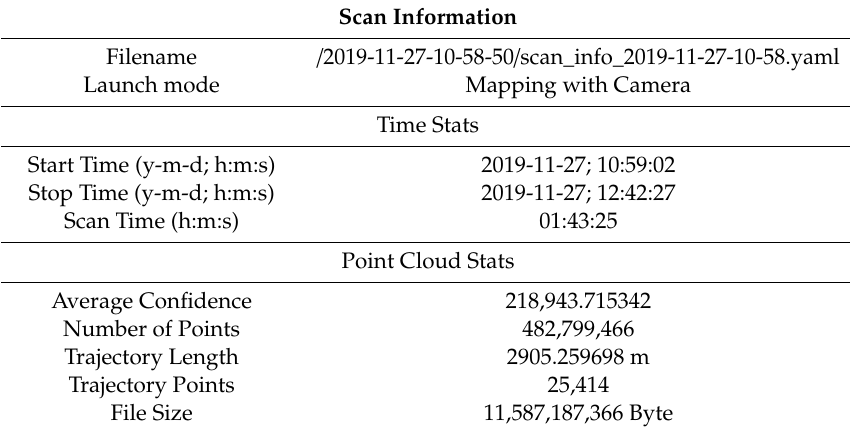
Table 4. Scan info of the estimated trajectory executed with mobile mapping system (MMS) Kaarta Stencil